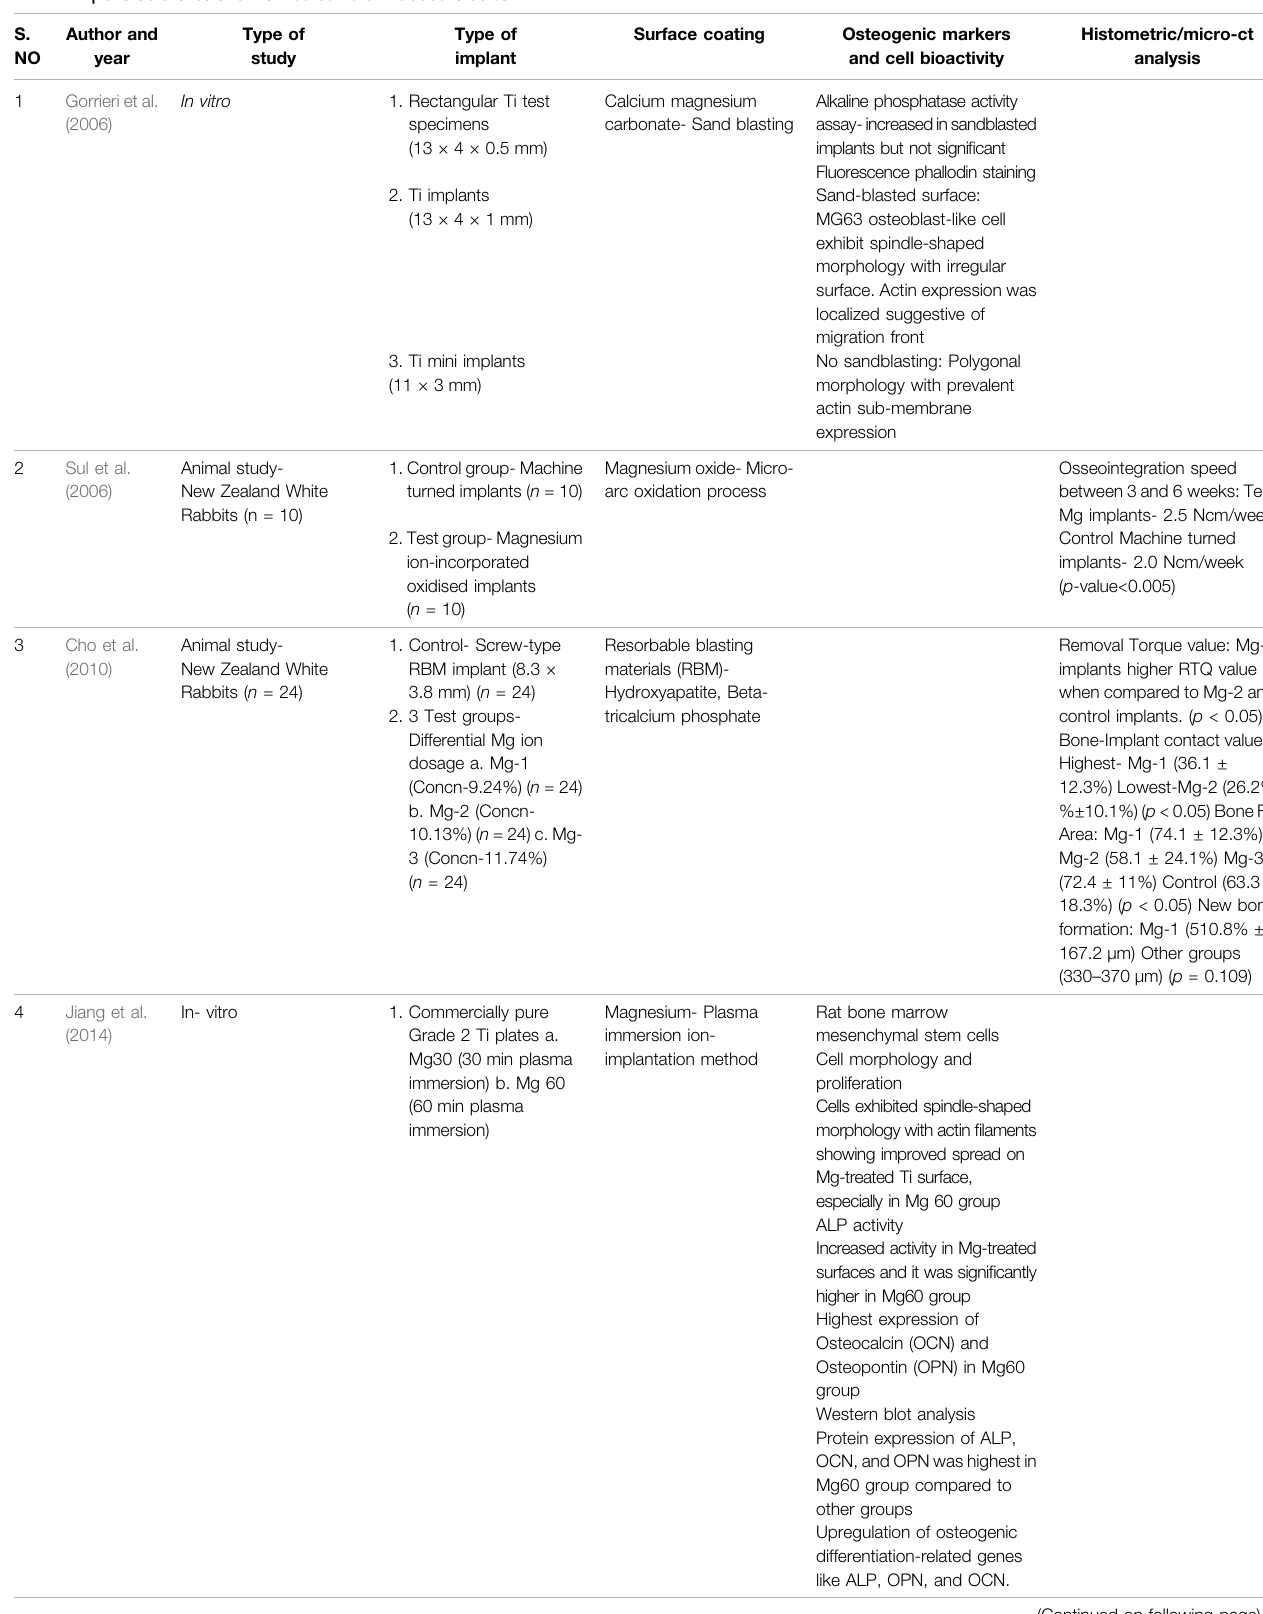
TABLE 1 | Characteristics and Main outcome of Included